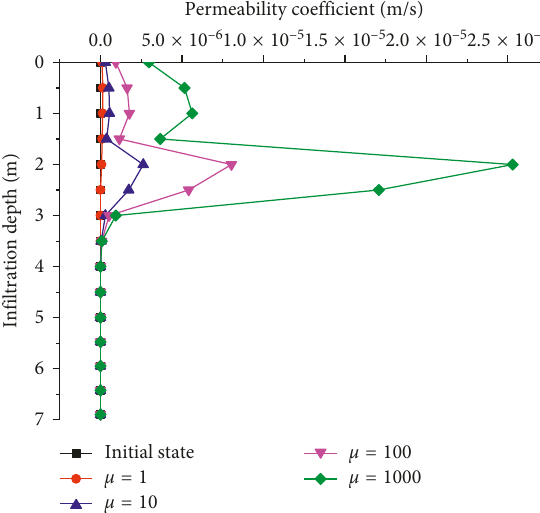
Figure 8: Distribution curve of the permeability coefficient with depth in different fracture permeability coefficient ratios ( x �